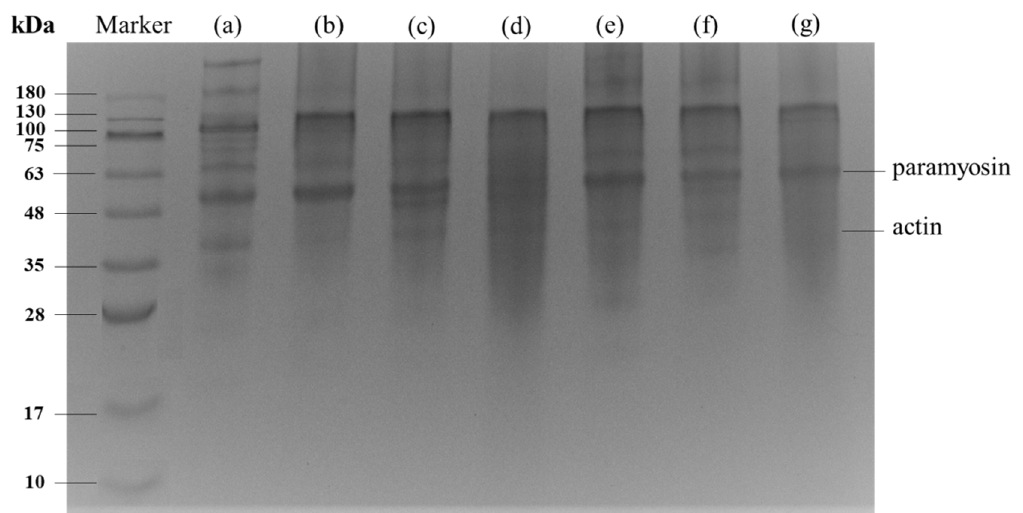
Figure 3. SDS-PAGE analysis of proteins in neritic squid fillets subjected to different softening methods: ( a ) raw squid; ( b ) control: untreated sterilized sample; ( c ) injected with 0.3% papain solution; ( d ) soaked in 1.0% papain solution in vacuum orbital shaker; ( e ) 1.0% papain solution in ultrasonic processor; ( f ) soaked in 2% NaHCO 3 solution with ultrasonic cleaning; ( g ) rehydrated after hot-air drying.